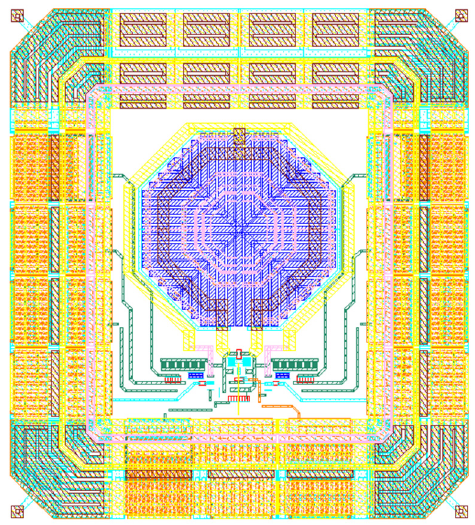
Figure 7. The layout of the proposed VCO. As shown in Figure 8, the phase noise at 1 MHz offset is − 101.9.4 dBc/Hz at 26.9 GHz and − 107.1 dBc/Hz at 22.2 GHz. In mm-wave, Q of varactors greatly limits the perfor- mance of VCOs. When the MOS varactors are working in accumulation region or depletion region, the Q of the capacitor is proportional to L − 2 and L − 1 , respectively [2]. To optimize the phase noise, the channel length should be the shortest.